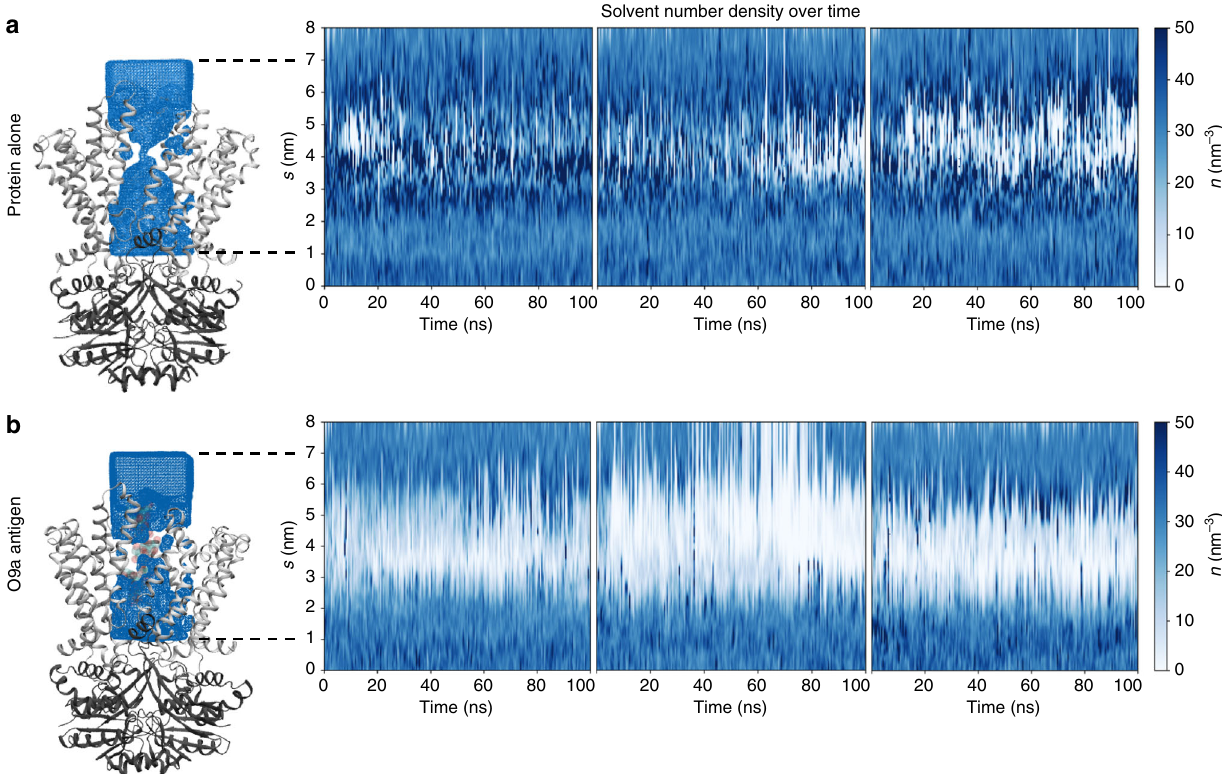
Fig. 3 Water fl ux through WzmWzt is prevented by substrate. a Snapshot of AaWzmWzt following 100 ns atomistic simulation, showing only the protein (Wzm in light gray, Wzt in dark gray) and a small region of water density around Wzm (blue). A column of water can be seen through the center of Wzm. Right: Quanti fi cation of the water solvent density, n , across the 100 ns simulation. The Y -axis, s , represents the position along the channel axis. Data from three repeats are shown. b Substrate-engaged transporter, with the sugars of the substrate shown as green and red transparent spheres. Right: Quanti fi cation of the water solvent density plotted the same as in